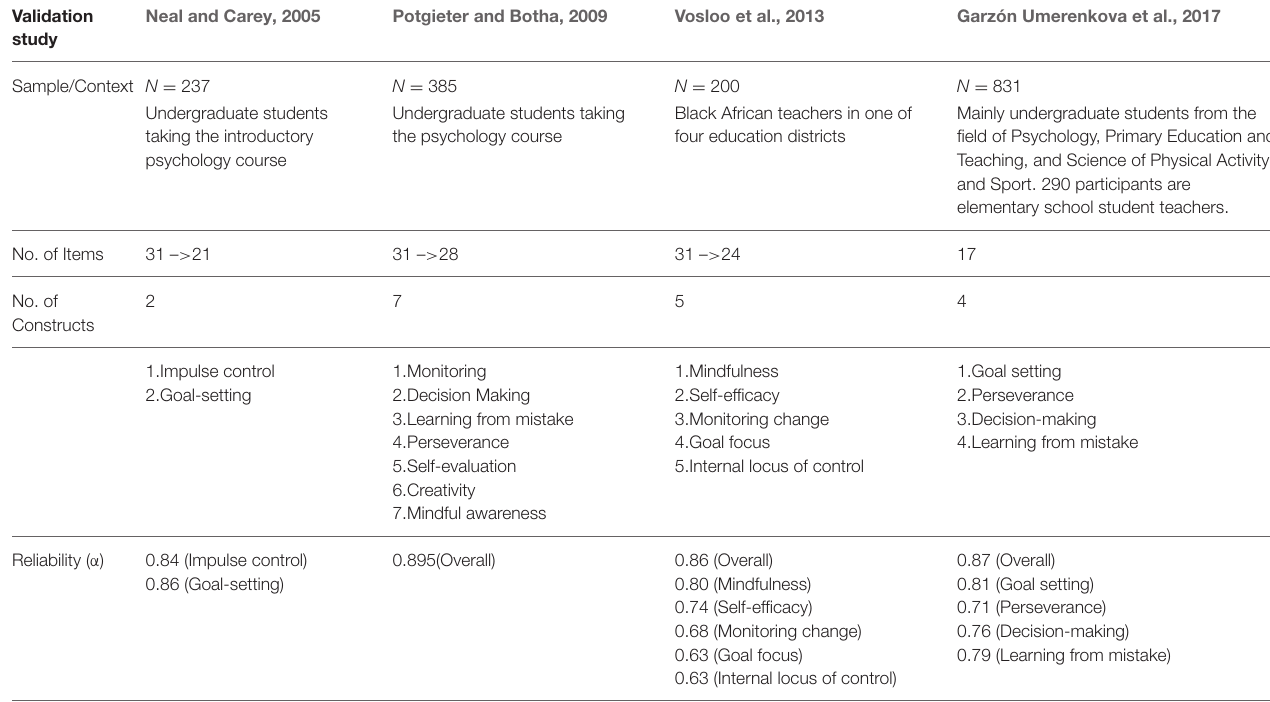
TABLE 1 | Validation studies of SSRQ.